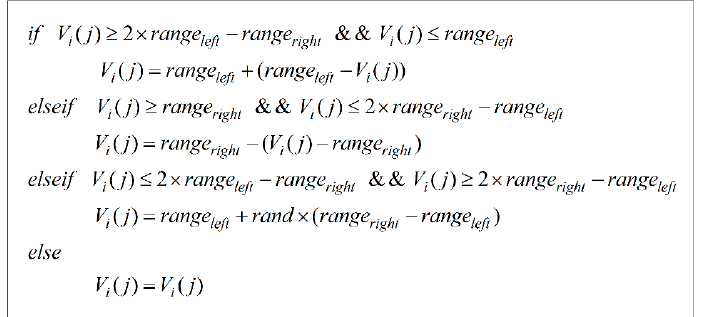
Figure 7. Symmetric mapping processing strategy.